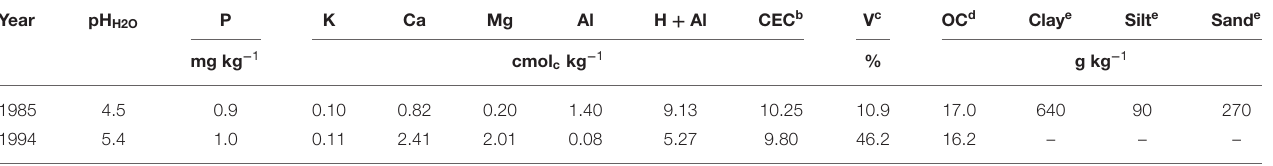
TABLE 1 | Soil chemical analysis a of the 0–20cm layer in two moments prior to the experiment establishment, before and after liming, as in Nunes et al.